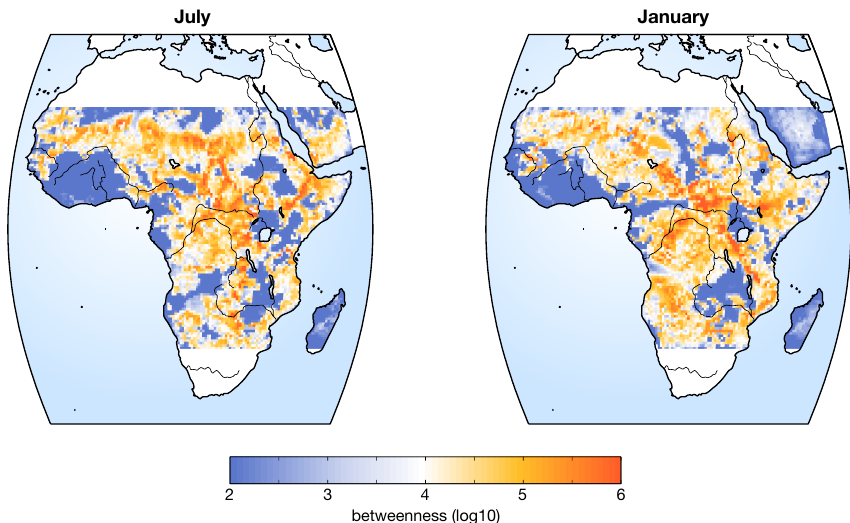
Figure 19. Shortest-path betweenness of regional African rainfall networks for July and January